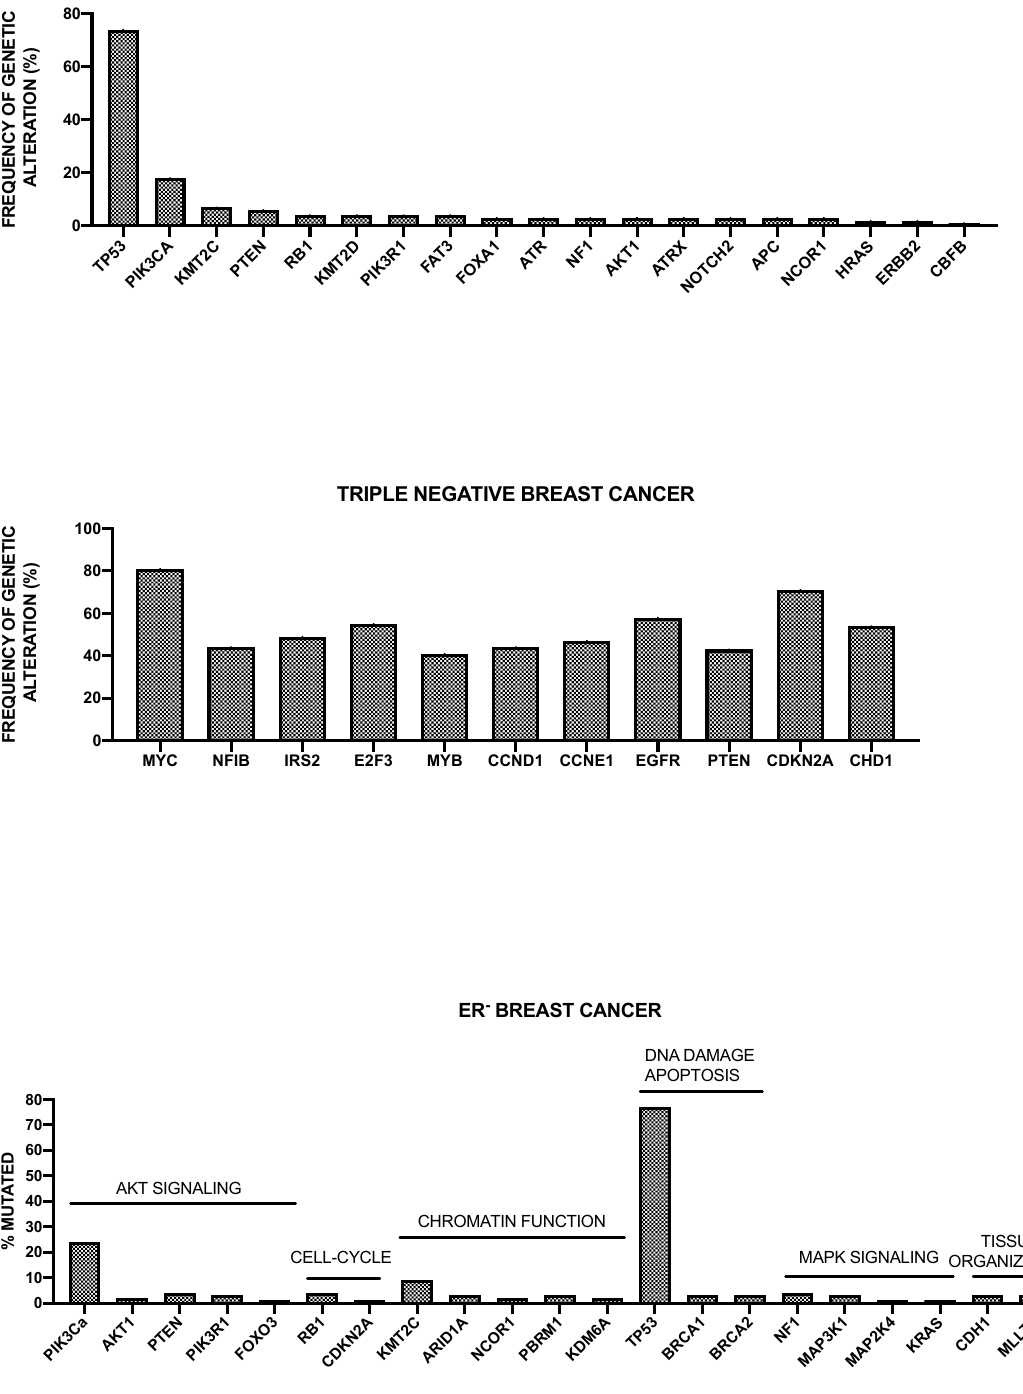
Figure 3. Genetic alterations observed in triple-negative breast cancers (TNBC). Top and middle panels: most recurrent somatic mutations (top panel) and copy number alterations (middle panel) observed in TNBC. The data shown are reported in Jiang et al. 2019 [119]. Bottom panel: most recurrent somatic mutations, subdivided according to functional gene groups, observed in estrogen receptor (ER)-negative breast cancers. The data shown are reported in Pereira et al. 2016 [49]. Bareche and coworkers analyzed the data that were related to TNBC patients on CNAs, somatic mutations, and gene expression contained in TCGA and Molecular Taxonomy of Breast